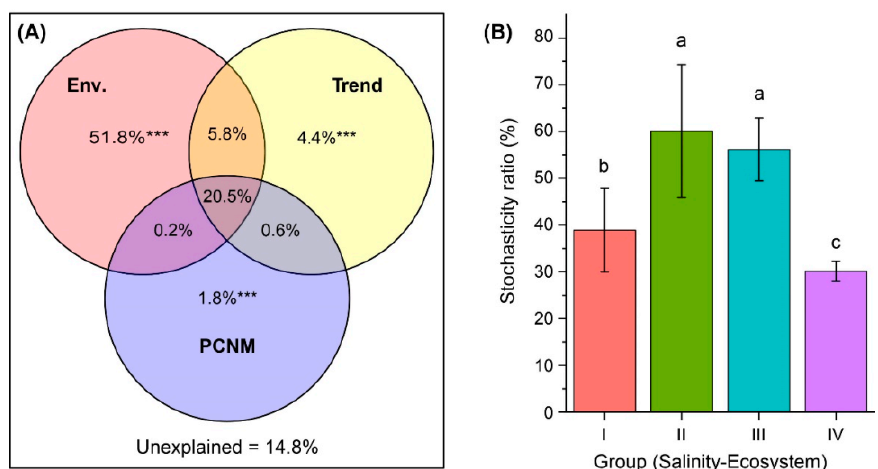
Figure 6. Drivers of bacterial community composition (BCC) and assembly. ( A ) Venn diagram pre- senting the partitioning results for the variations in BCC by environmental variables (Env.), and the spatial variables of linear trend and principal coordinates of neighbor matrices (PCNM). The fraction values displayed are computed from adjusted R-squares. *** Permutation test p -value = 0.001. ( B ) Rel- ative importance of stochastic mechanism in community assembly in freshwater rivers (Group I, mean salinity = 0.21‰), freshwater lakes (Group II, mean salinity = 0.44‰), low-brackish Lake Dalinor (Group III, mean salinity = 6.22‰), and high-brackish Lake Daihai (Group IV, mean salinity = 11.36‰). Different lower-case letters indicate significant differences ( p < 0.01) among